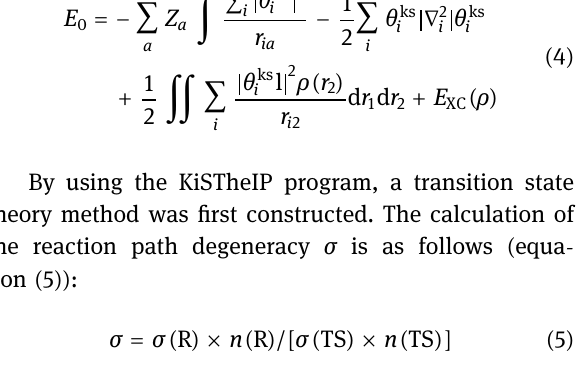
Rate constant ( cm 3 /molec/s )